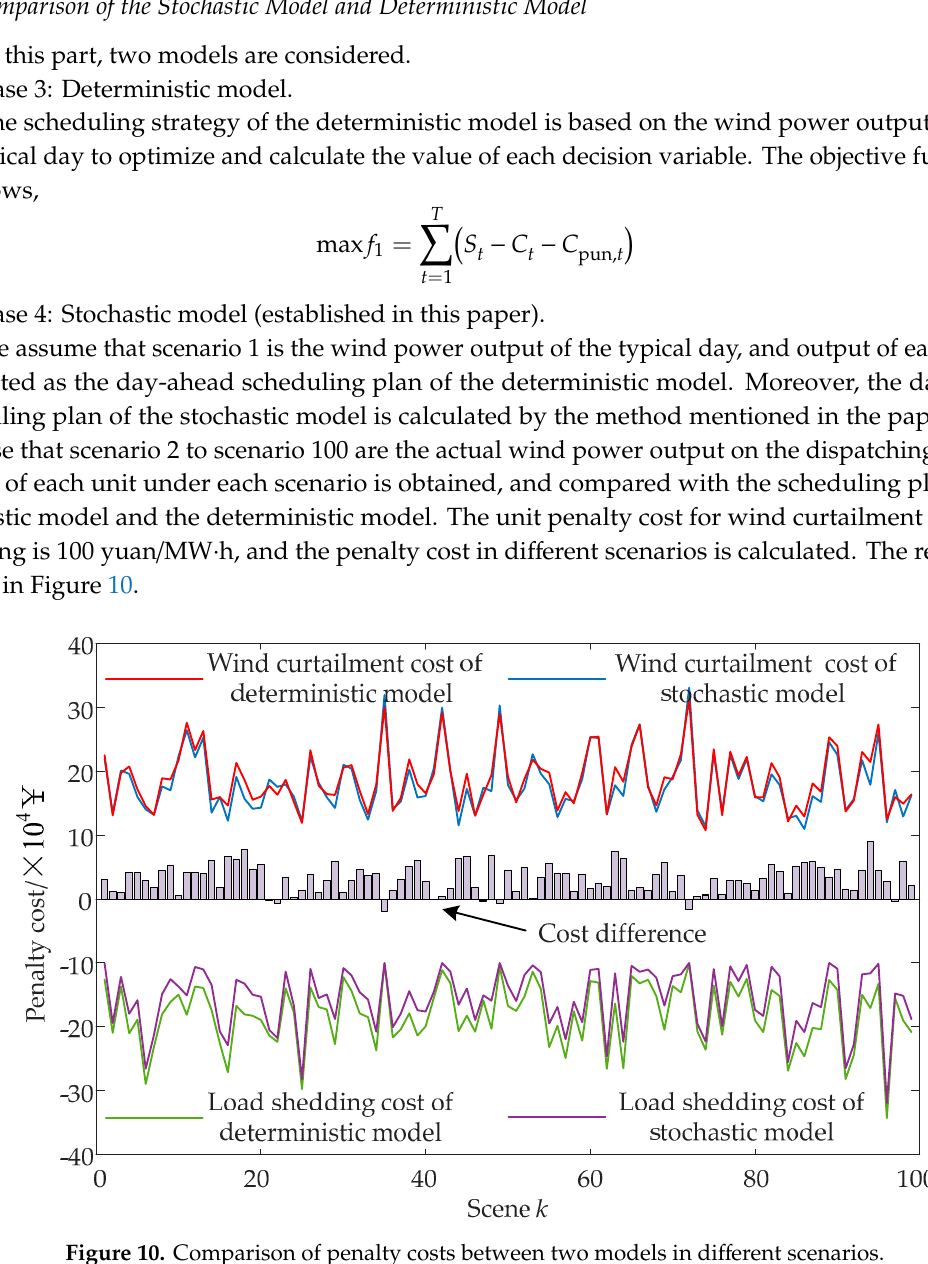
Figure 10. Comparison of penalty costs between two models in different scenarios.